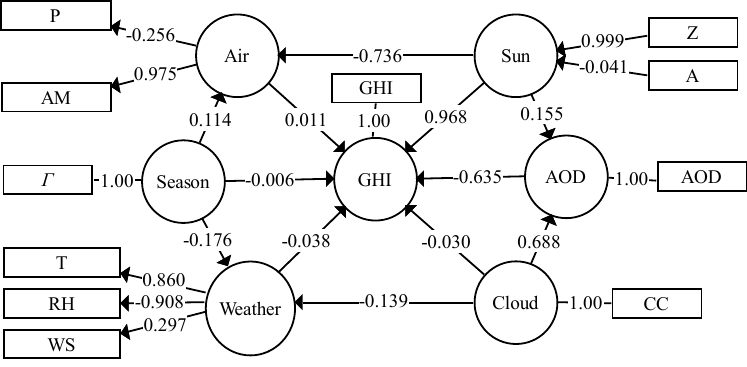
Figure 4. Path graph model between GHI and 10 factors. P is station pressure, AM is airmass, Z is the cosine function of the solar zenith angle, A is the solar azimuth angle, AOD is aerosol optical depth, T is temperature, RH is relative humidity, WS is wind speed, and CC is cloud cover. The number on each line is the normalized path coefficient of each variable. Table 3. Comprehensive path coefficients of 10 factors relevant to GHI.